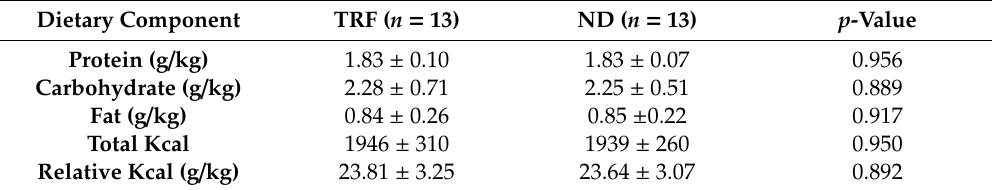
Table 2. Macronutrient and calorie intake averages across the four week investigation (two weekdays and one weekend day per week was